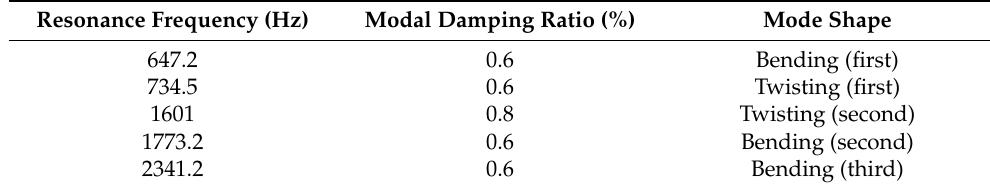
Table 1. Modal parameters of 304SS specimen.